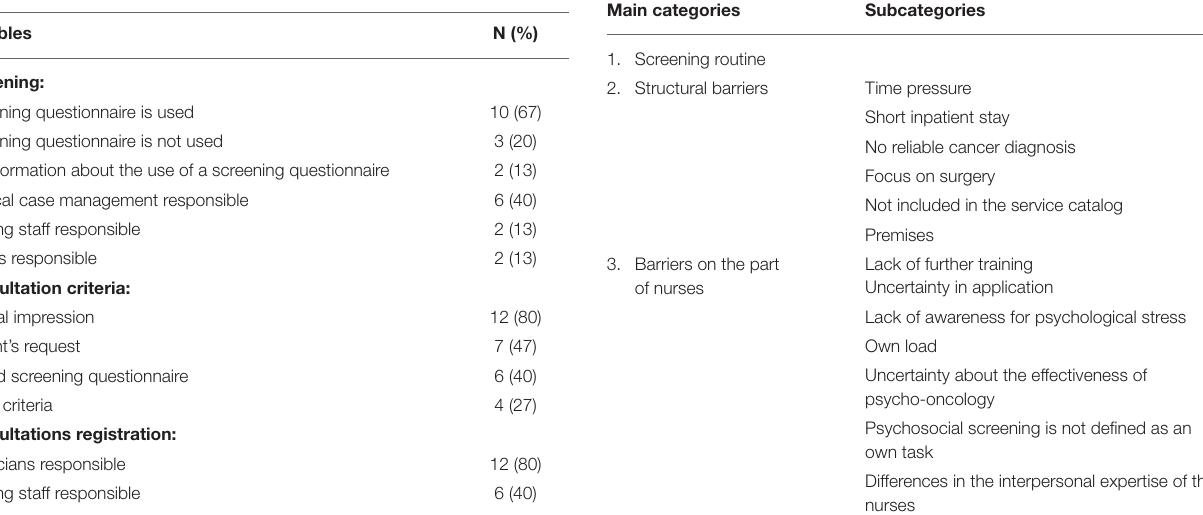
TABLE 2 | Overview of psycho-oncological screening and consultations registration.